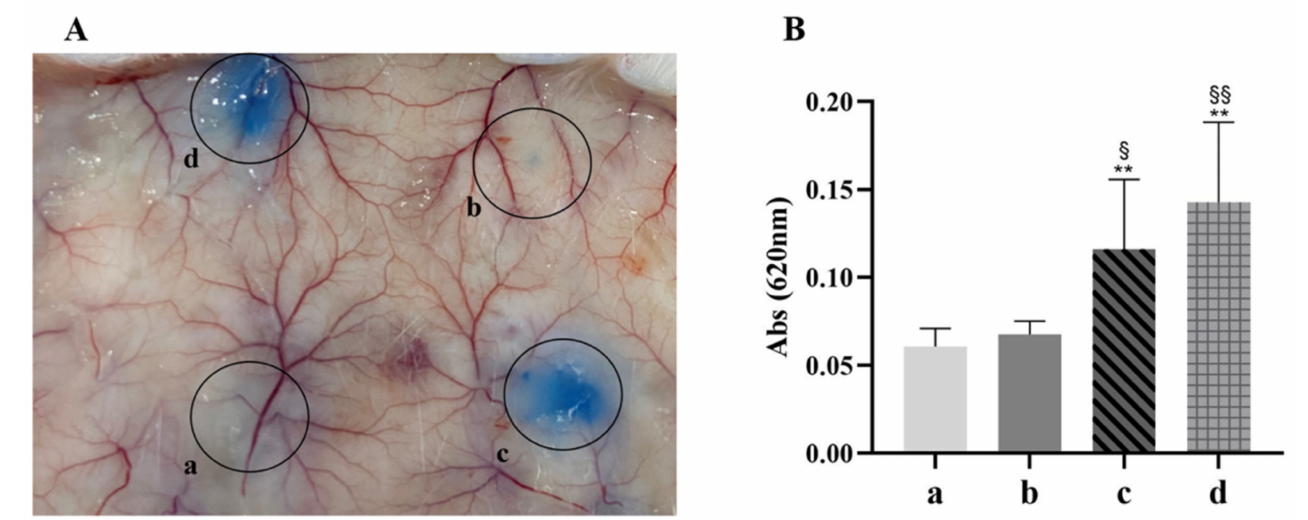
Figure 3. Evans blue aggregation of mouse dermis ( A ) and Evans blue absorption peak at 620 nm ( B ). a: PBS, b: pET-32 α , c: rSsTCTP, d: Compound 48/80. ( A ) A representative result of six